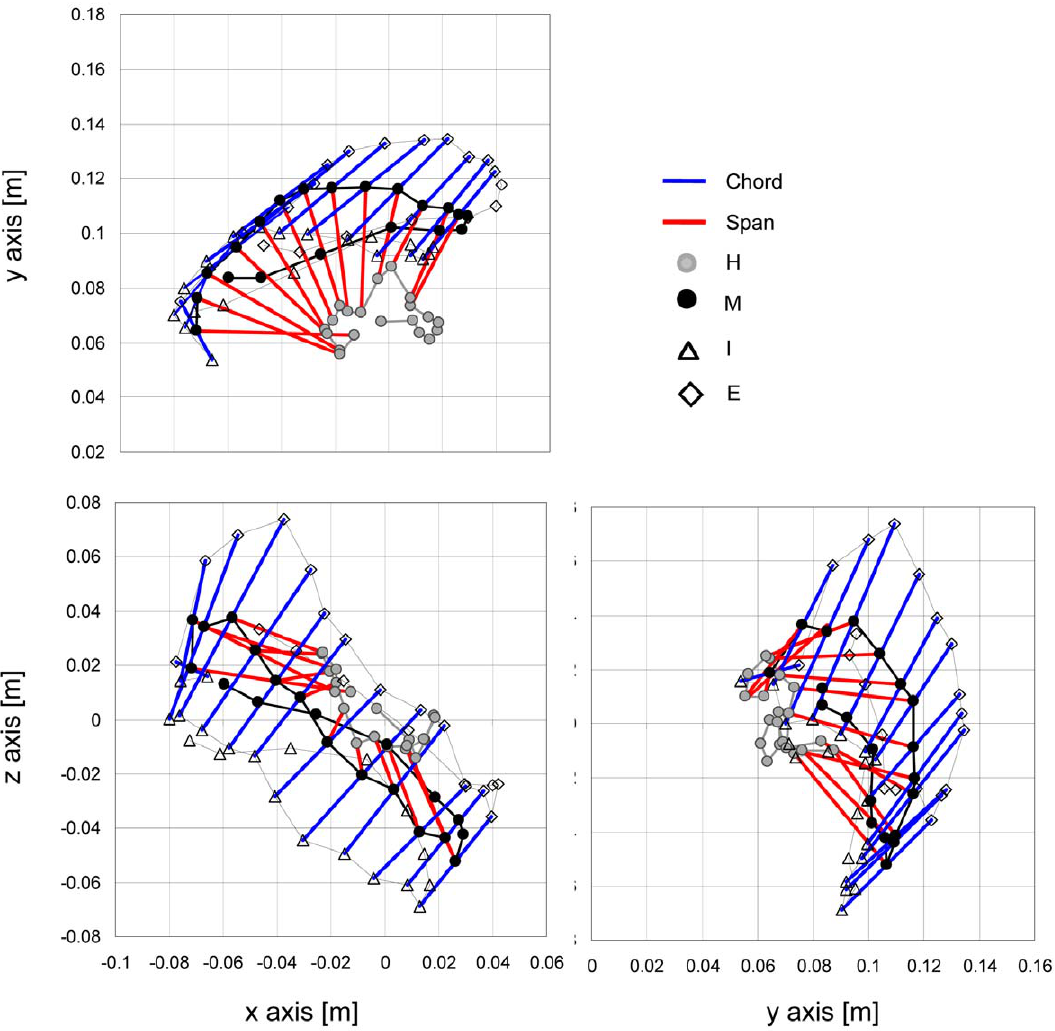
Figure 3. The 3D kinematics of the foot in the duck (x,y,z) frame of reference. The data shown was extracted from two video cameras showing the motion of the left foot of a duck during a single paddling cycle. Shown are the positions of the tip of the internal (I, see Fig. 1) and external (E) toes as well as the calculated tip of the mid toe (M) and the base of the foot (H) every 5% of the paddling cycle duration. The blue lines connecting E and I represent the chord of the foot, the red lines are the span (HM in Figure 1) of the foot. These lines are shown only for the last 60% of the paddling cycle when the webbed area of the foot is spread (the power phase). Upper panel shows the motion of the foot in the xy plane, left and right figures in the lower panel show the same motion in the xz and zy planes